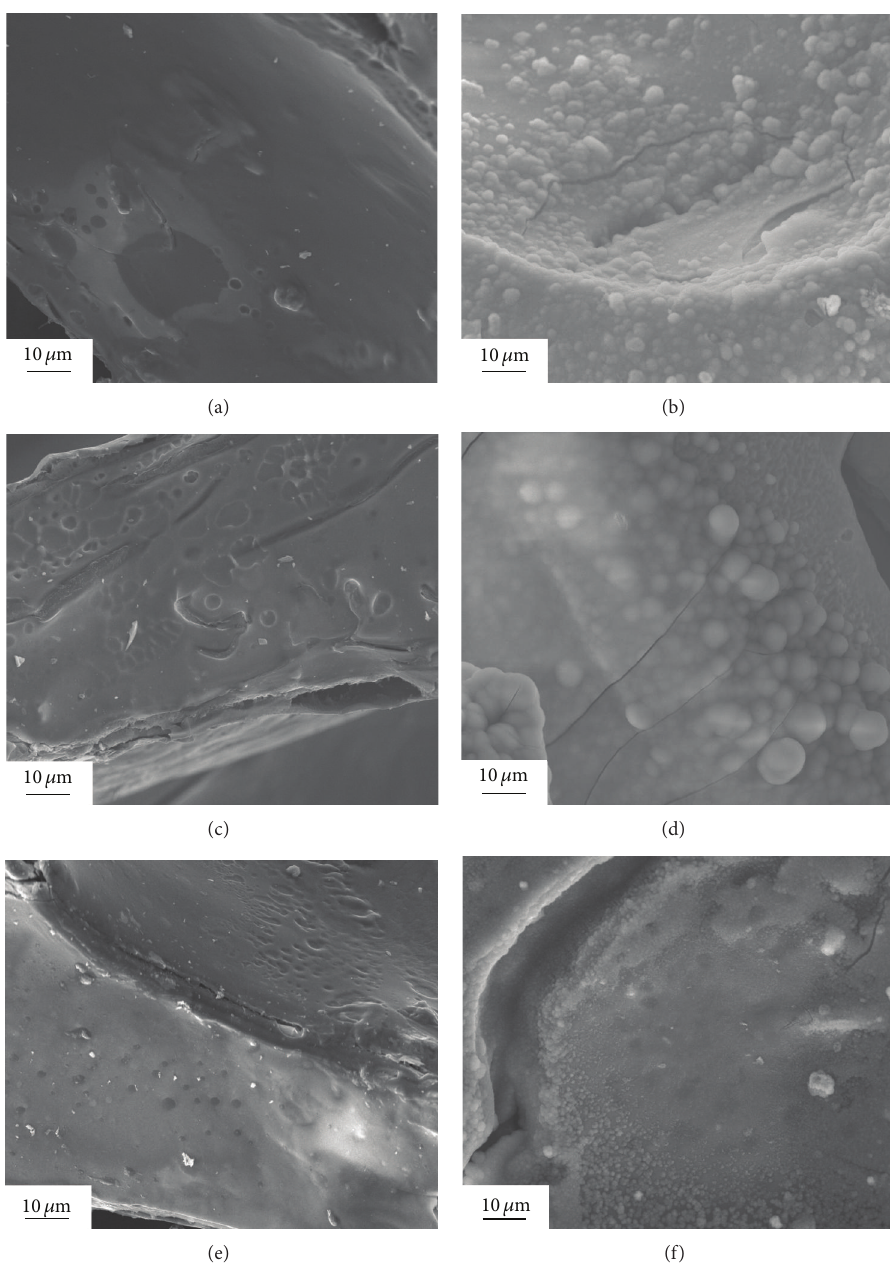
Figure 8: SEM images of the Fe-MBG/C composite scaffolds before (a, c, and e) and after (b, d, and f) soaking in SBF solutions for 3 days ((a) and (b) for the 0Fe-MBG/C scaffolds; (c) and (d) for the 5Fe-MBG/C scaffolds; (e) and (f) for the 10Fe-MBG/C